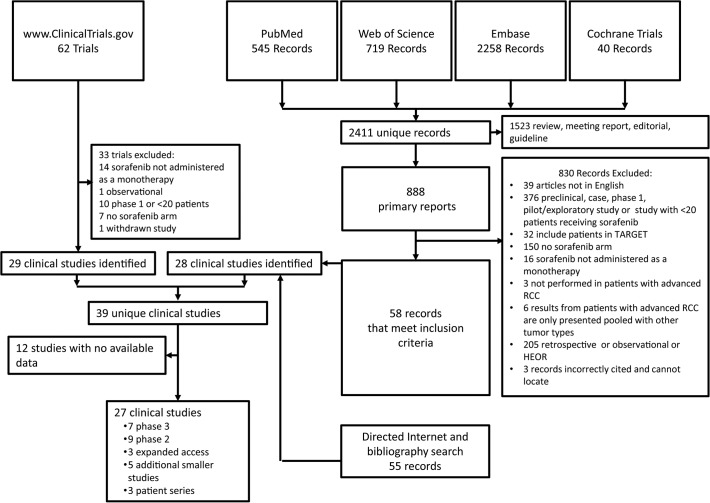
Flow of information.Selection process for included trials.